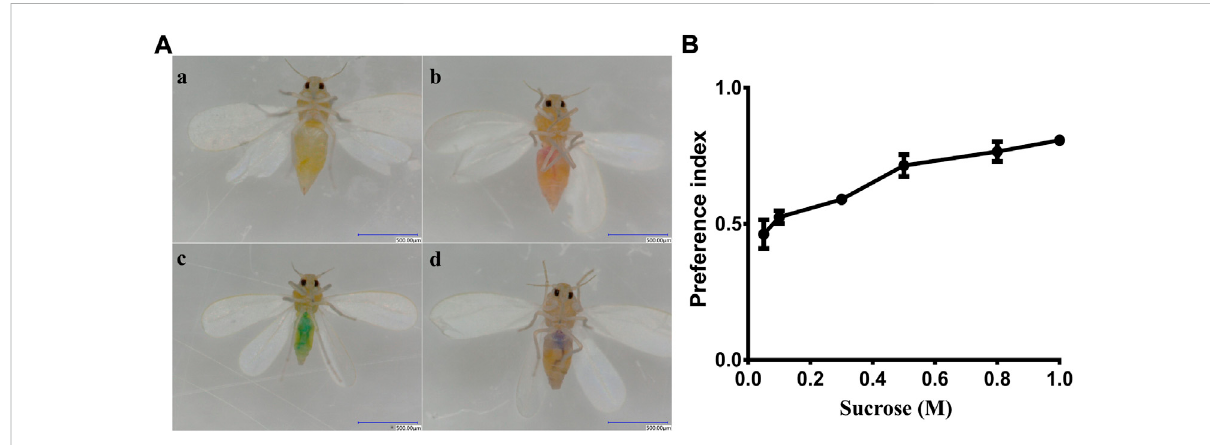
FIGURE 6 Preferenceindexoffemalewhite fl yafterinterferenceofBtGR11. (A) themRNArelativeexpressionoftheBtGR11afterinterfering. (B) Preference index of female white fl y for sucrose, control: untreated group, dsEGFP mean EGFP control group, and dsBtGR11 mean BtGR11 RNAi experimental group. * mean p < 0.05.